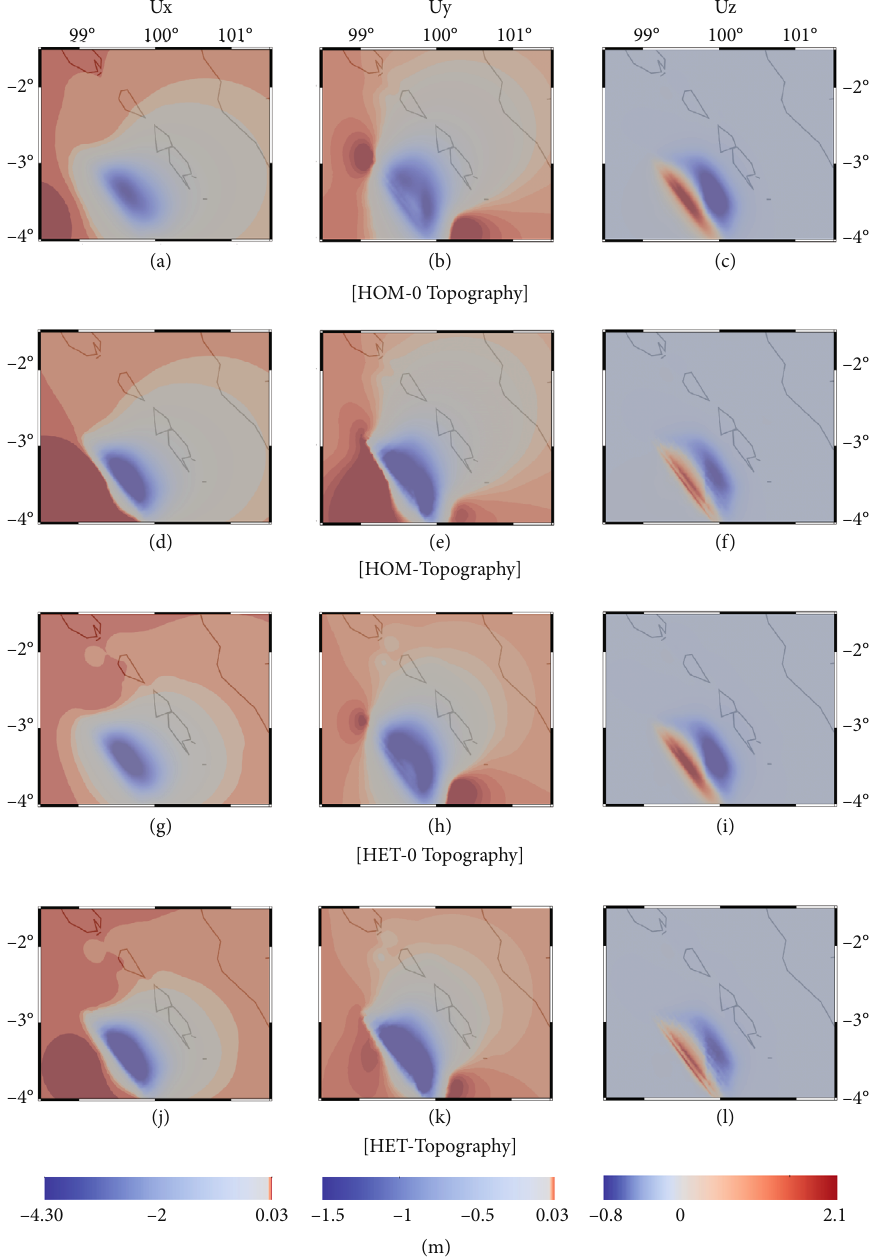
Figure 5: Three components of the surface deformation for the homogenous-heterogeneous and zero topography-topography model. Left to right are displacement Ux, Uy, and Uz. (a – c) Homogenous-zero topography model (HOM-topo0). (d – f) Homogeneous model- topography model. (g – i) Heterogeneous-zero topography model. (j – l) Heterogeneous-topography model. Scale bar shows the displacement value in